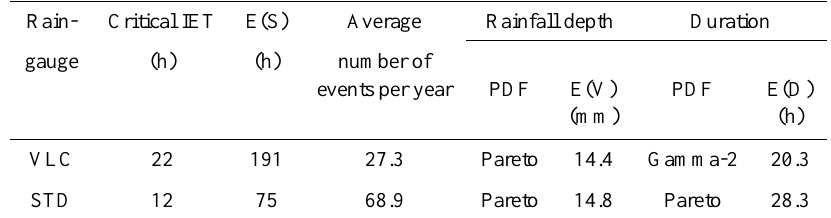
Table 6. Comparison between Valencia (VLC) and Santander (STD) rainfall